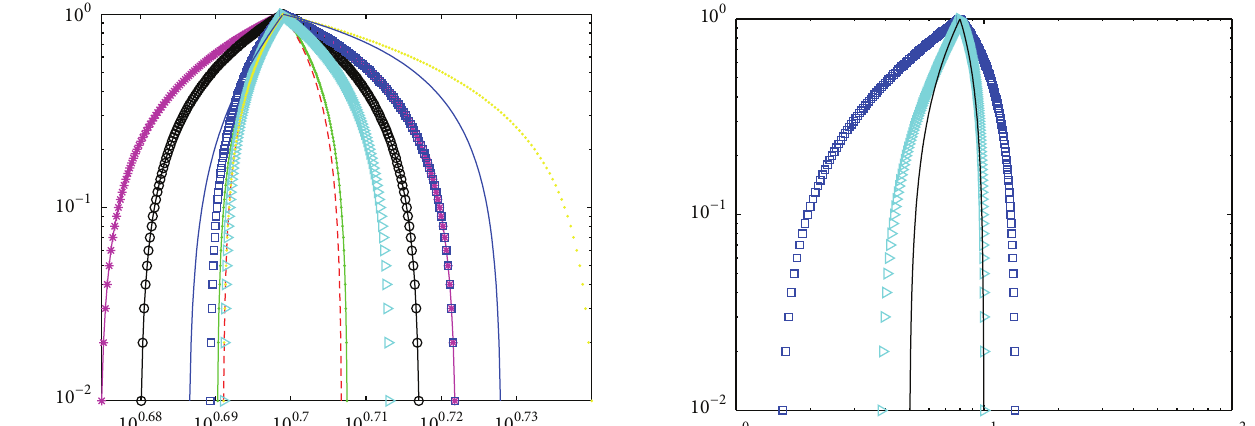
Figure 5: Compare and ̃𝑥 +,𝑙,𝑢 𝐺 (◻) .